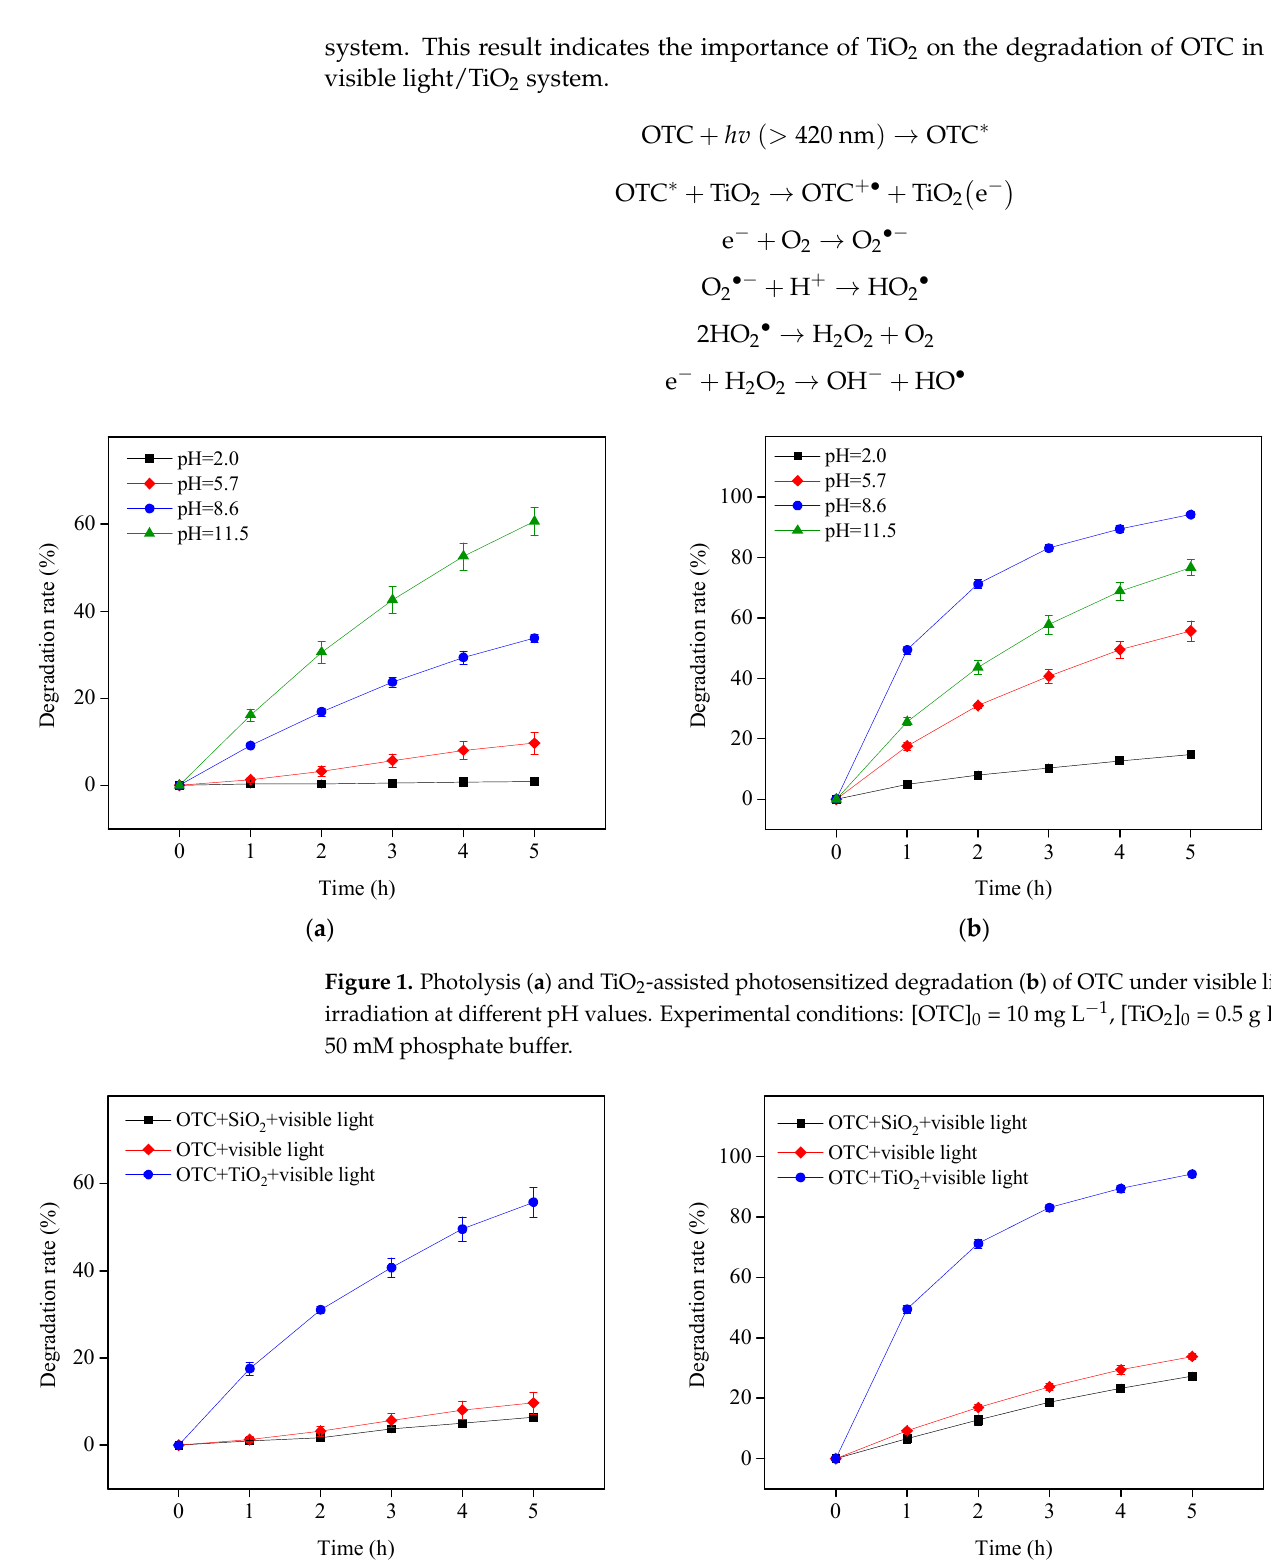
Figure 3. OTC adsorption on TiO 2 at different pH values. Experimental conditions: [OTC] 0 = 10 mg L − 1 , [TiO 2 ] 0 = 0.5 g L − 1 , 50 mM phosphate buffer. 3.2. Identification of Reactive Oxygen Species 3.2.1. Photolysis Process The photolysis of OTC under visible light irradiation included two different path- ways, direct photolytic degradation and indirect self-photosensitized degradation. To identify the ROS dominantly responsible for the self-sensitized OTC degradation during photolysis under the study’s visible light irradiation conditions, different ROS scavengers were added to the reaction solutions. As shown in Figure 4, NaN 3 , p -benzoquinone, cata- lase, and t-BuOH are respective scavengers of 1 O 2 , O 2• − , H 2 O 2 , and HO • . With the addition of p -benzoquinone, the OTC degradation was slightly inhibited at pH 8.6 but significantly depressed at pH 11.5. Visible light OTC decomposition in the presence of the other ROS scavengers was similar to OTC photolysis at both pH values. These results indicated that O 2• − was generated and that OTC photolysis mainly involved direct degradation and O 2• − - induced self-sensitized degradation under the study’s visible light irradiation conditions. Niu et al. [17] came to the same conclusion.